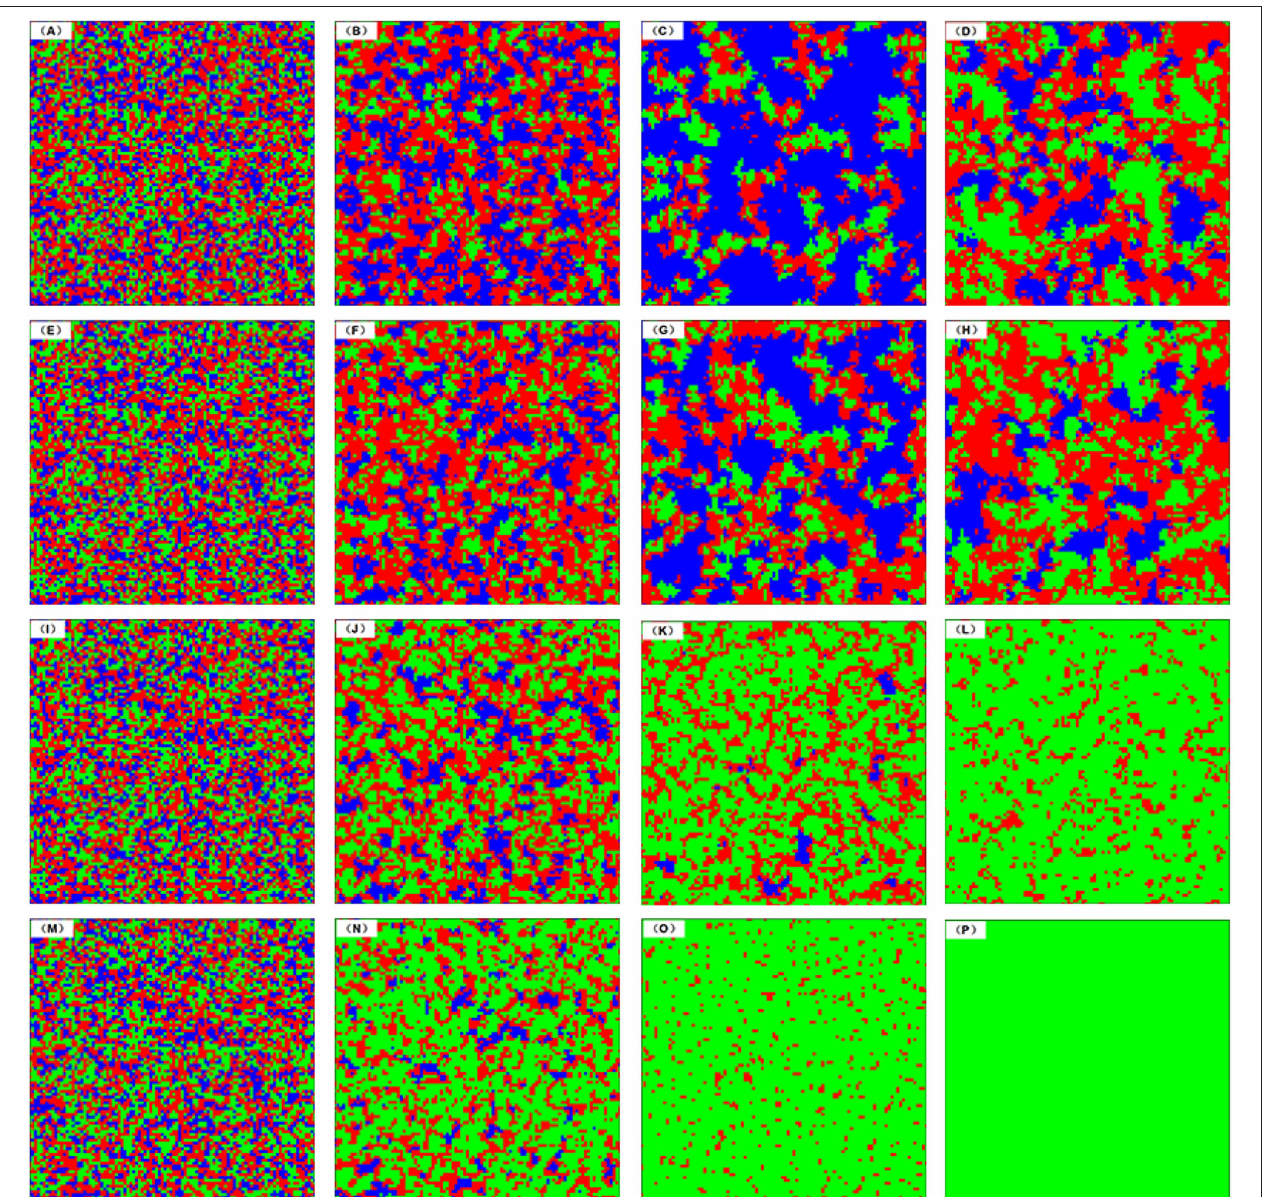
FIGURE 5 | Characteristic snapshots of the spatial distribution of three strategies for different reciprocal rewarding strength β and time step in the voluntary PDG. The row from top to bottom, β takes the value to be 0.0, 0.2, 0.3, and 0.5, respectively. The column from left to right, the snapshots are acquired at MCS steps 0, 5, 20, and 5 × 10 4 , respectively. In all panels, the red dots represent defectors, the green ones express cooperators and the blue ones stand for loners. In all simulations, other parameters are set to be L = 100, MCS = 5 × 10 4 , σ = 0.3, b = 1.28, K =